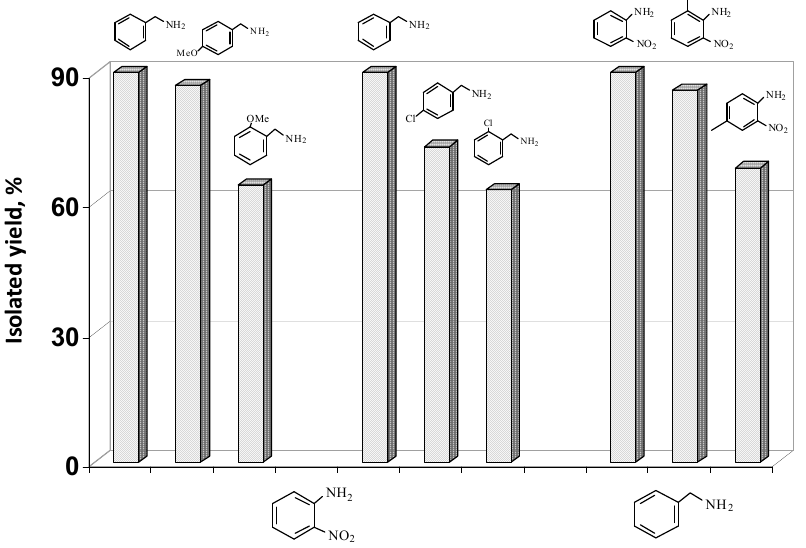
Figure 3. Synthesis of different 2-phenylbenzimidazoles in the presence of ZIF-67 (experimental conditions: 2.0 mmol of 2-nitroaniline, 6.0 mmol of benzylamine, 5 mol.% of catalyst, 1 mL of DMSO, air atmosphere, 413 K, 24 h). Figure ref. [68] was adapted with the permission from Else ‐ vier